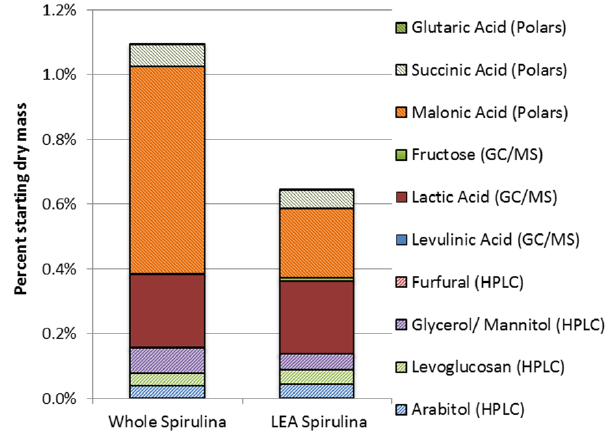
Figure 7. High value chemicals identified from HPLC and GC/MS analysis of sugars and polars in the aqueous fraction from HTC treatment of Spirulina at 175 °C for 30 min. Results are shown as a percentage of starting dry